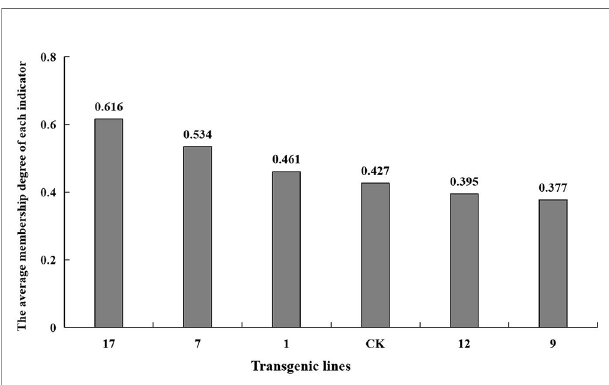
FIGURE 8 | The average membership degree of each indicator. The average membership degree of transgenic lines (1, 7, 9, 12, 17) and non-transgenic lines (CK) are listed from highest to